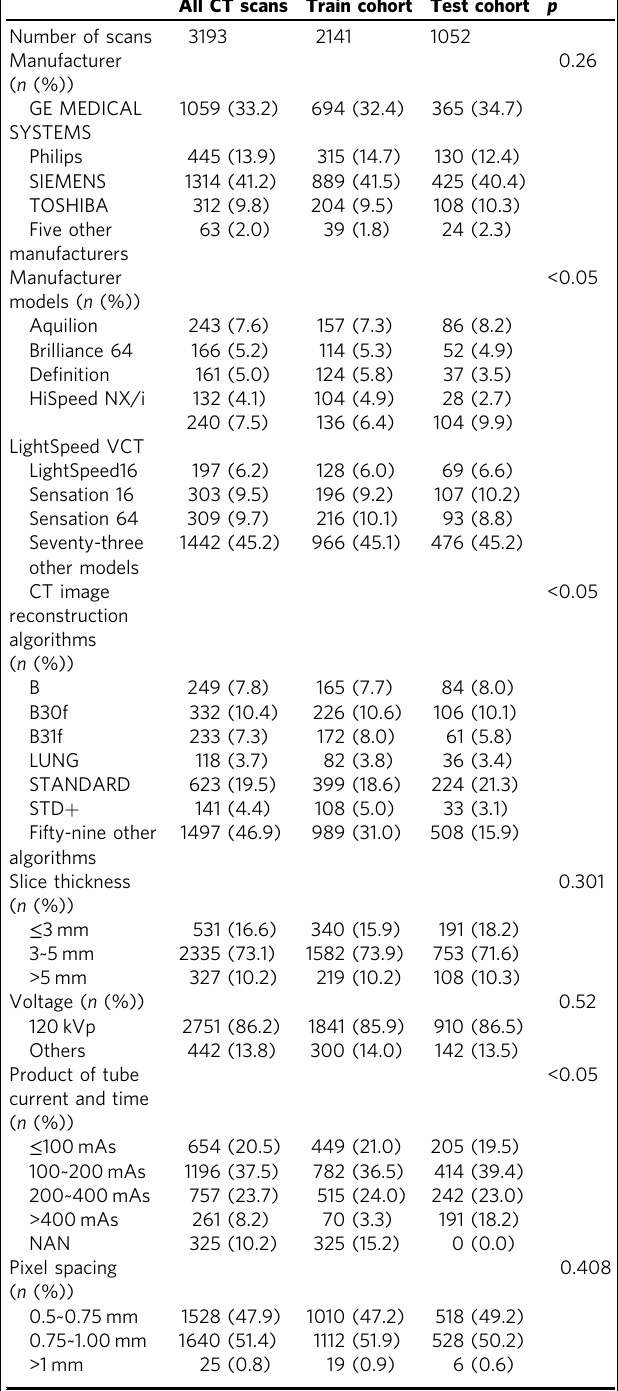
Note: p -Values were calculated via two-sided chi-square